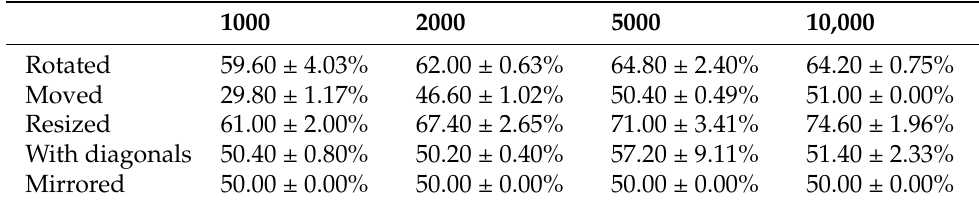
Table 6. The number of transformed objects: 5; Level of noise: